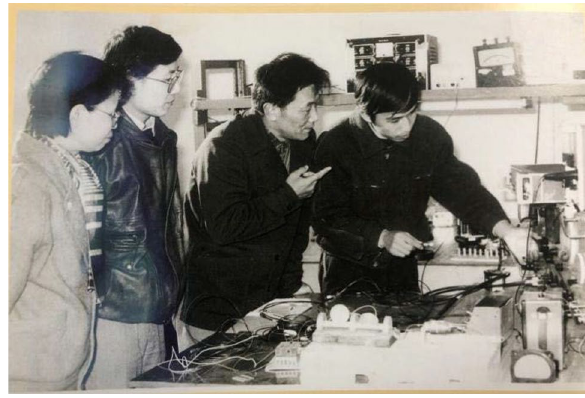
Fig. 2 Dexiu Huang (second from right) conducting research in the